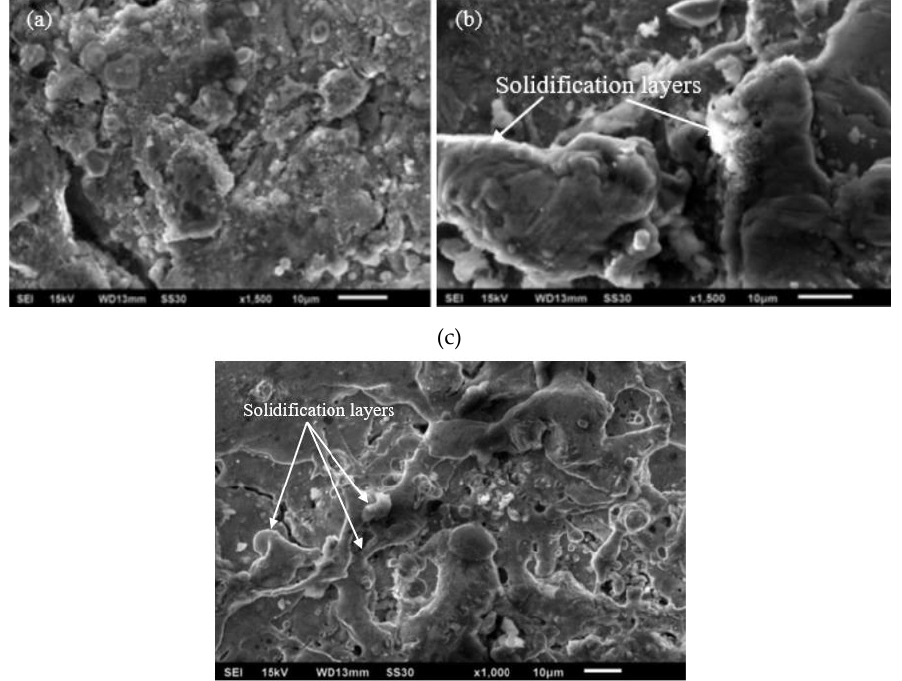
Figure 5. Scanning electron microscope (SEM) analysis of workpieces after machining ( a , b ): Al-12%, ( c ) Al-18%. (Note: EDM parameters for both ( a ) I = 10 (Amp), V= 4 (V), T on = 200 (µs) and copper electrode, and ( b , c ) I = 14 (Amp), V= 4 (V), T on = 200 (µs) and copper electrode.)